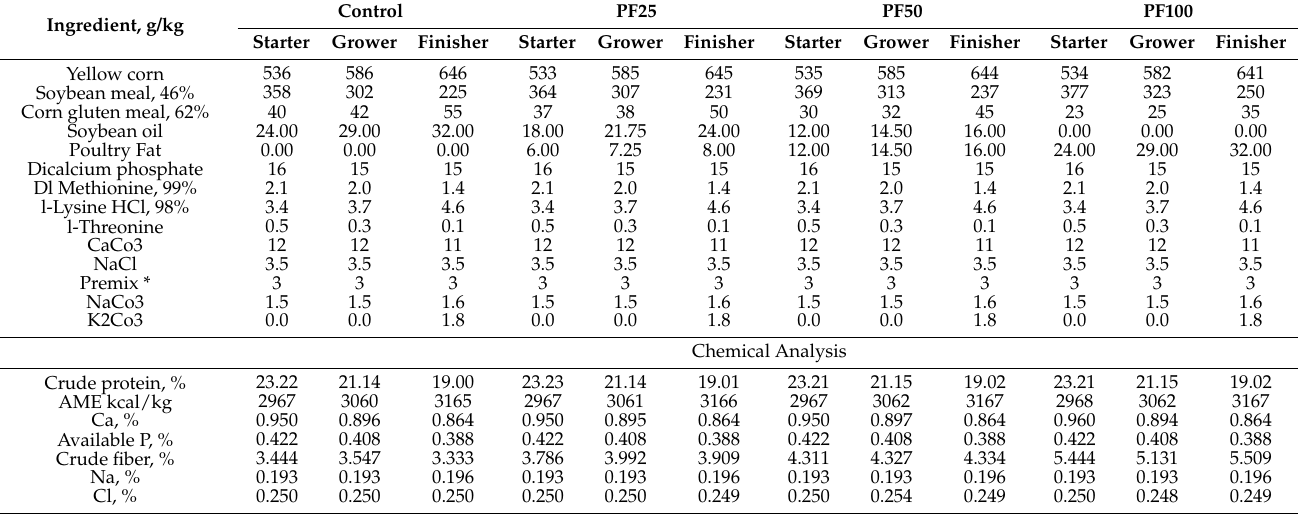
Table 1. Composition of the experimental starter (1–11 d), grower (11–24 d), and finisher (25–35 d)